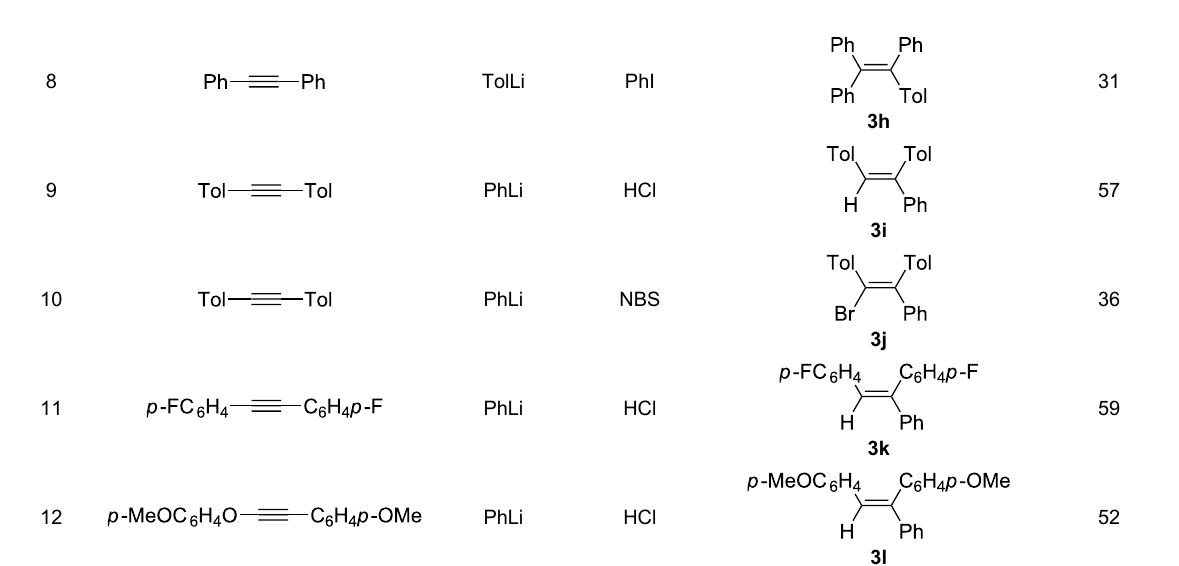
Table 1: Formation of multi-substituted olefins via the reaction of alkynes with [Cp 2 Zr(1-butene)(DMAP)] and aryllithium in the presence of TCQ a . (continued)